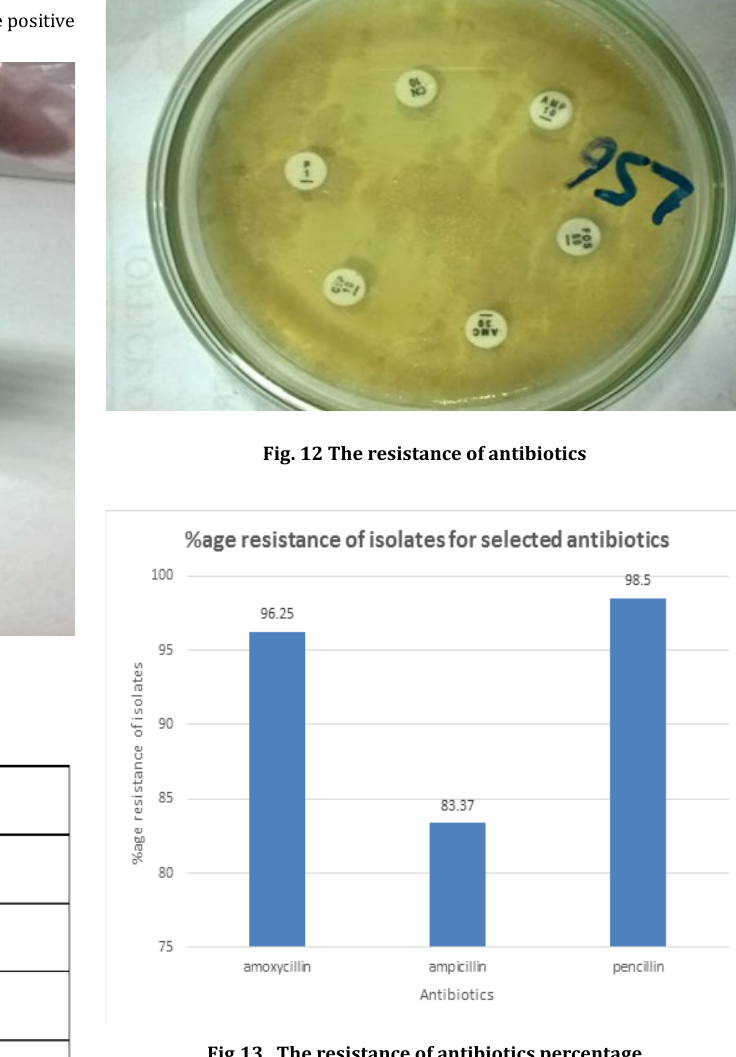
Fig.13 The resistance of antibiotics percentage